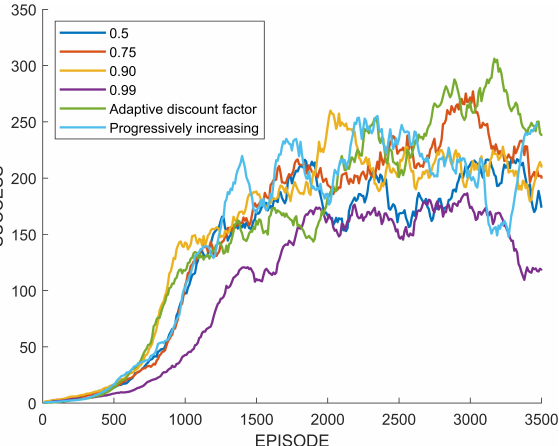
Figure 14. Perforamance of path planning in continuing